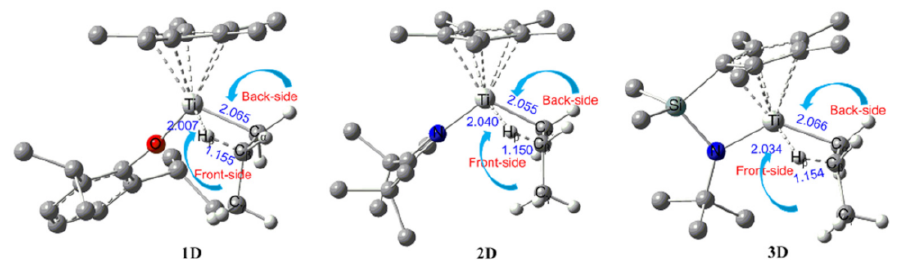
Figure 6. Optimized structures (distances in Å) of 1D , 2D , and 3D . Hydrogen atoms of the Cp* ligand and ancillary ligand have been omitted for